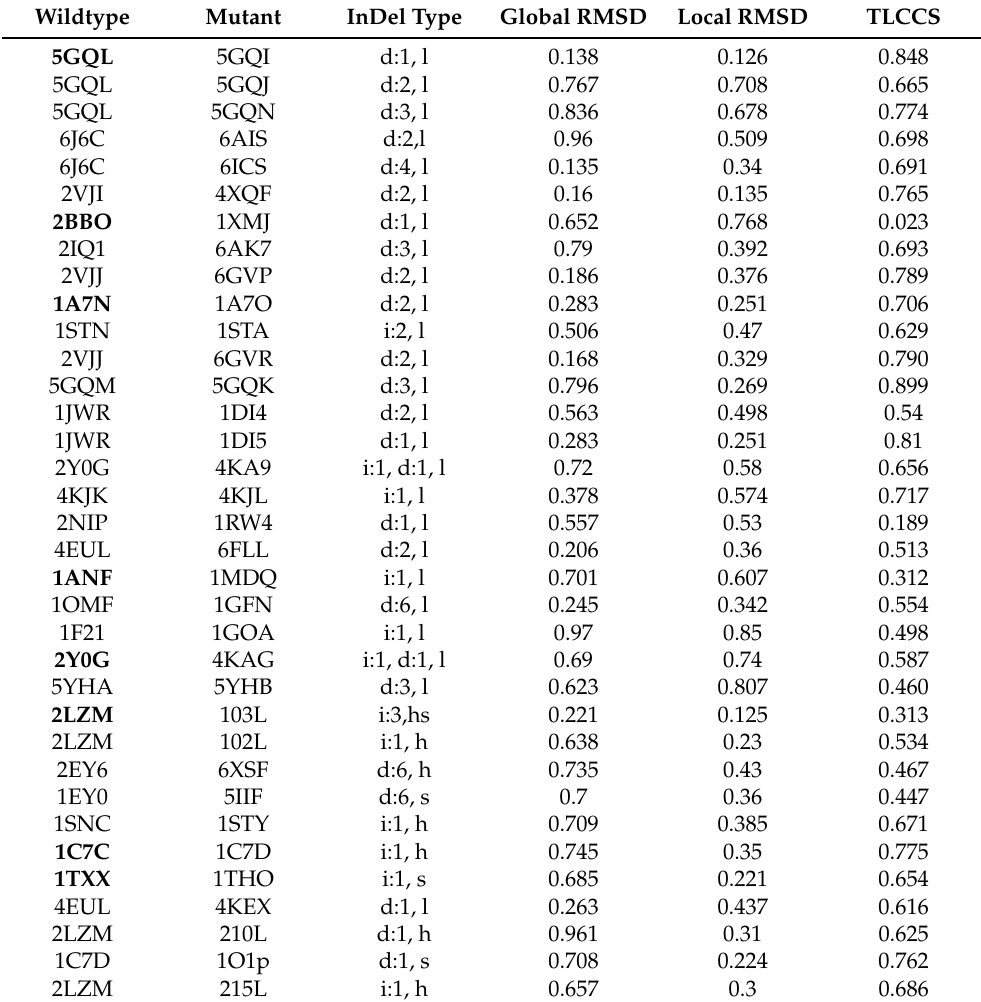
Table 1. Global and local RMSD of PDB and in silico generated InDel mutants in angstroms. TLCCS provides a quantitative measure of the difference between the two largest clusters of the wildtype and PDB mutant. The lower the value, the bigger the difference, with values 0.5 or lower being significantly